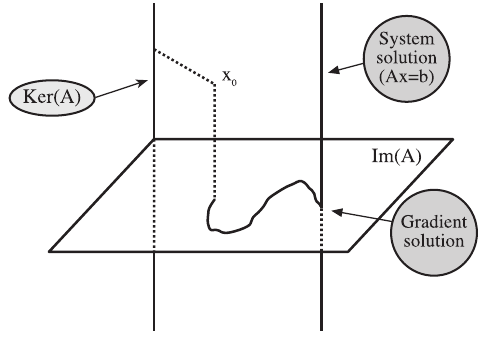
Fig. 9. A schematic view of the evolution of the so- lution in the admissible subspace Im ( A